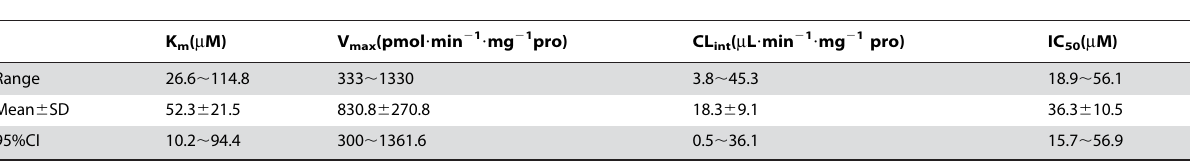
Table 2. The K m , V max and CL int for CYP1A2 and IC 50 of baicalin on CYP1A2 in HLMs (n= 28).